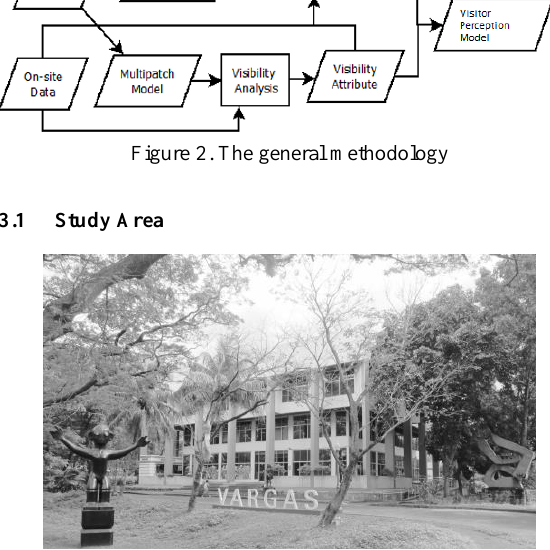
Figure 3. Perspective view of Vargas